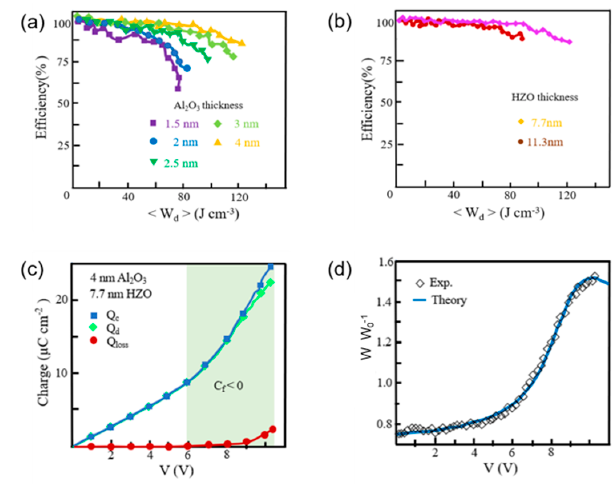
Figure 9. Plots of capacitor compounded with both a ferroelectric (HZO) and dielectric layer (Al 2 O 3 ) with various layer thicknesses. ( a ) Efficiency (%) versus discharged energy density 〈 W d 〉 (J/cm − 3 ) for 7.7 nm HZO compounded with 1.5 nm to 4 nm Al 2 O 3 layer thicknesses. ( b ) Efficiency (%) versus